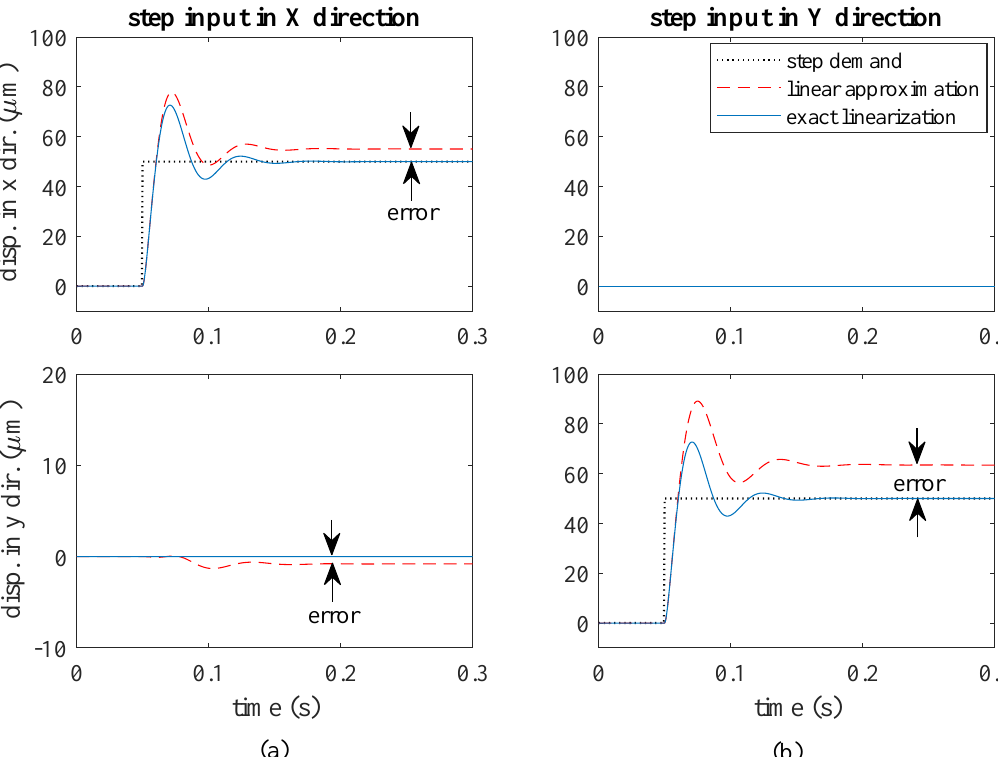
Figure 8. Simulations of DAMB with lumped-mass rotor for step-change in position demand ( a ) step input in X direction ( b ) step input in Y direction.